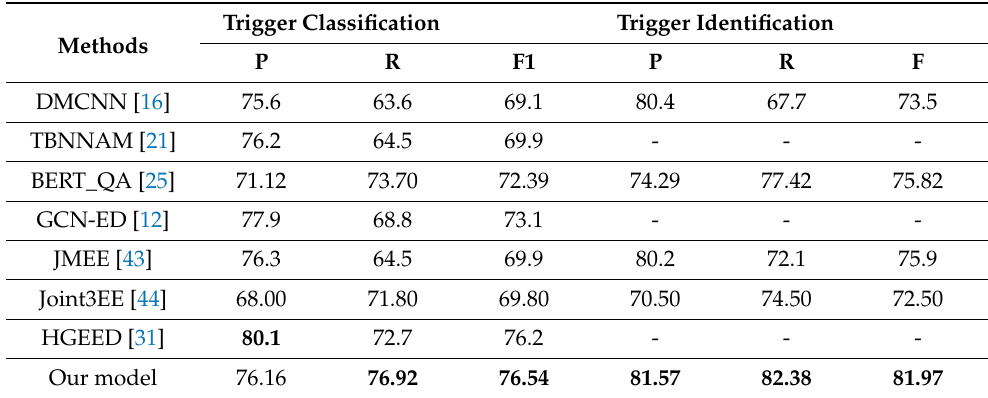
Table 3. Event detection results on ACE2005.